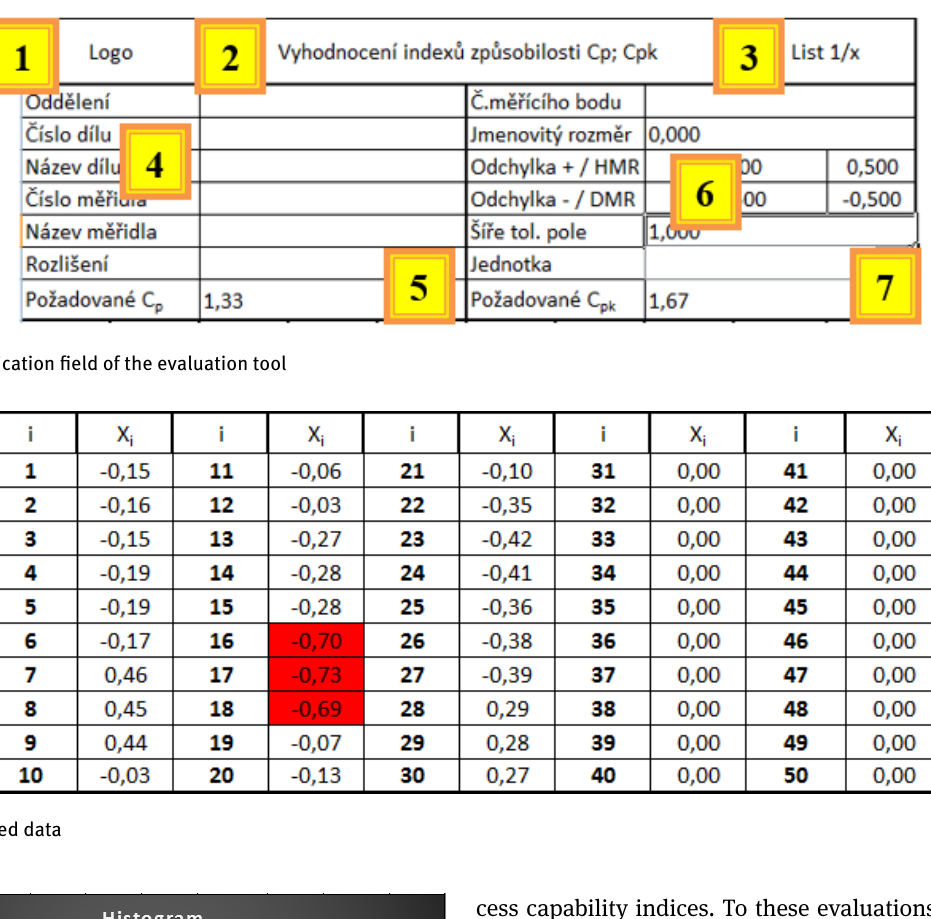
In the third part of the form there are graphs that are updated according to the loaded data. In the upper part of the figure, there is a histogram with a Gaussian curve. Its lower part depicts a graph showing the course of the measurement. This allows the operator to detect any fluc- tuations or inconsistencies. This is shown in Figure 4. And the last part of the form consists of calculations of basic statistical indicators, including calculation of